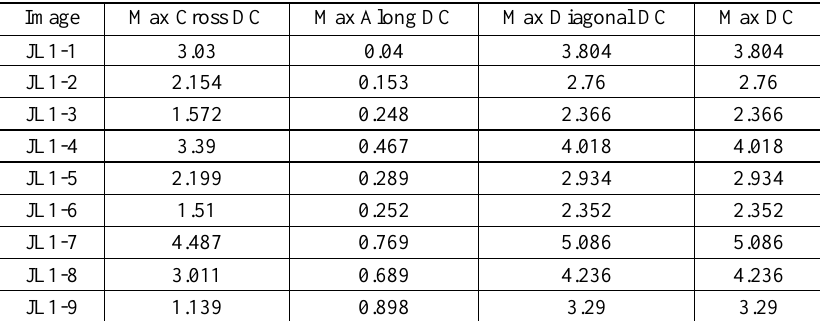
Table 5. The maximum deviation coefficients of JL1 dataset. The deviation coefficients in the table have been multiplied by 10 4 . Image